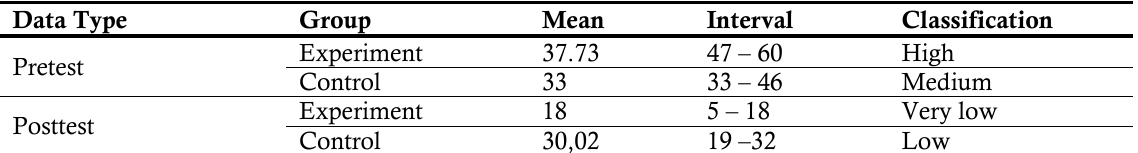
Table 4. The comparison of the pretest, posttest, dan gain score of experimental and control groups Data